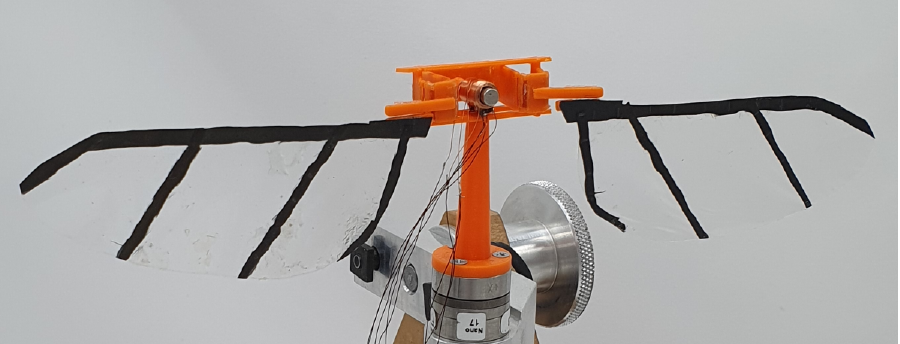
Figure 12. 3D-printed flapping wing system mounted on a force-torque sensor.